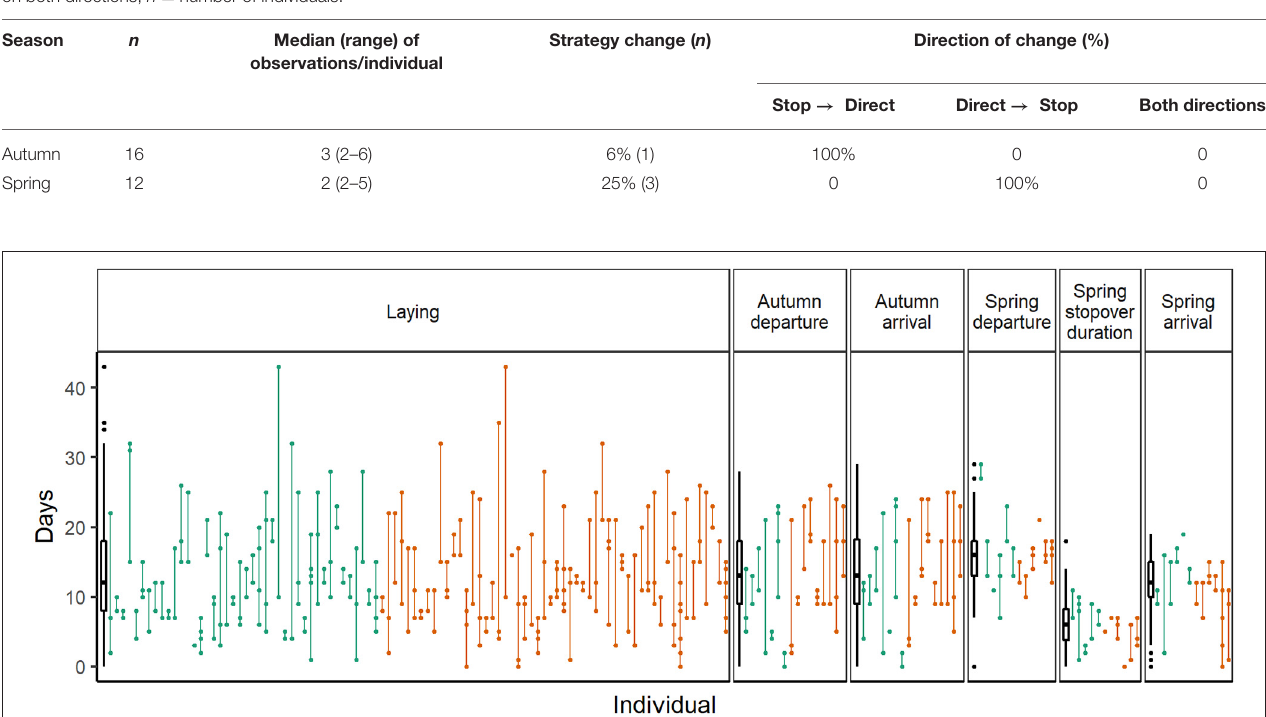
TABLE 1 | Direction and proportion of individuals that changed migratory strategy on each season (Autumn and Spring), from a stopover to direct, direct to stopover or on both directions; n = number of individuals.